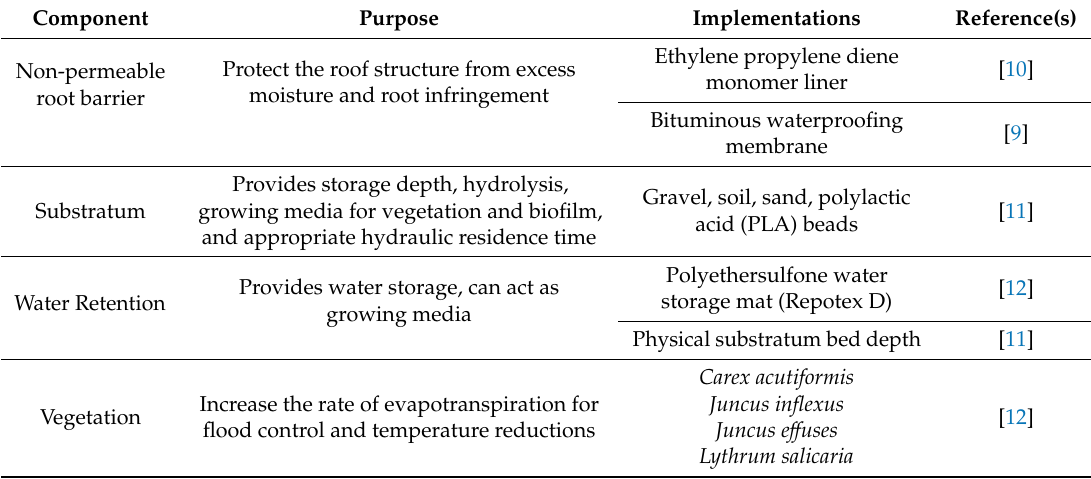
Table 2. Examples of wetland roof component materials from